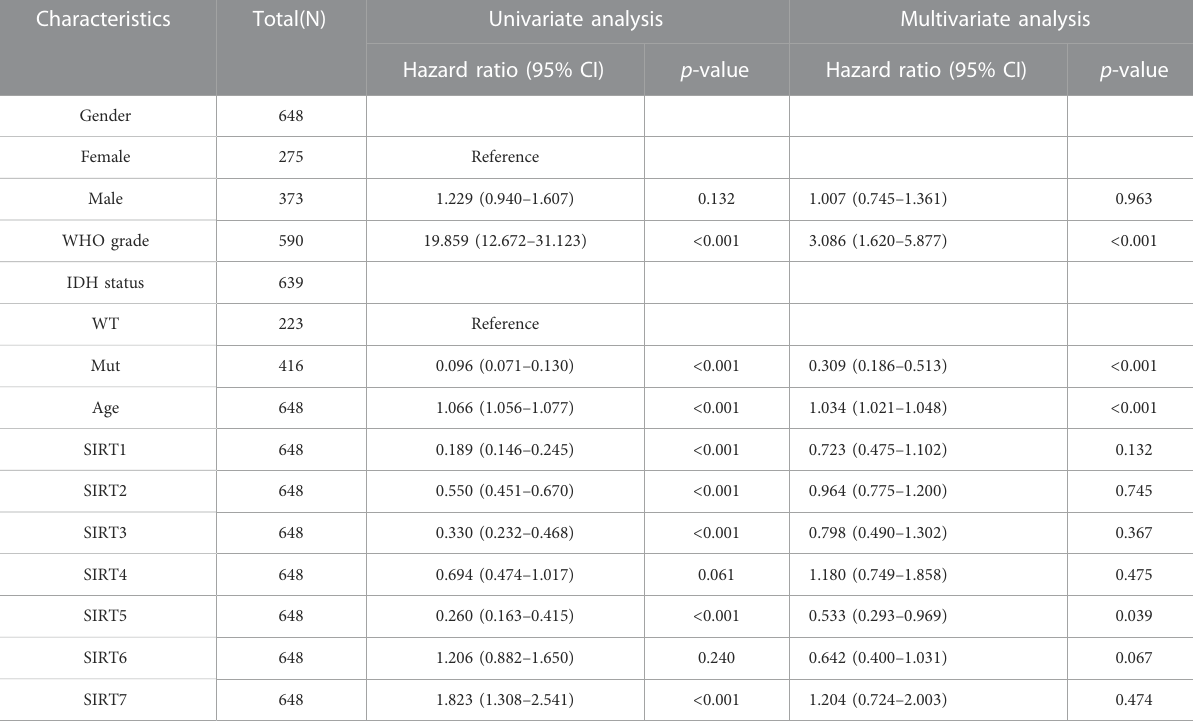
TABLE 2 The SIRT family and clinical features were analyzed by DSS-based univariate and multivariate Cox regression in the TCGA database.